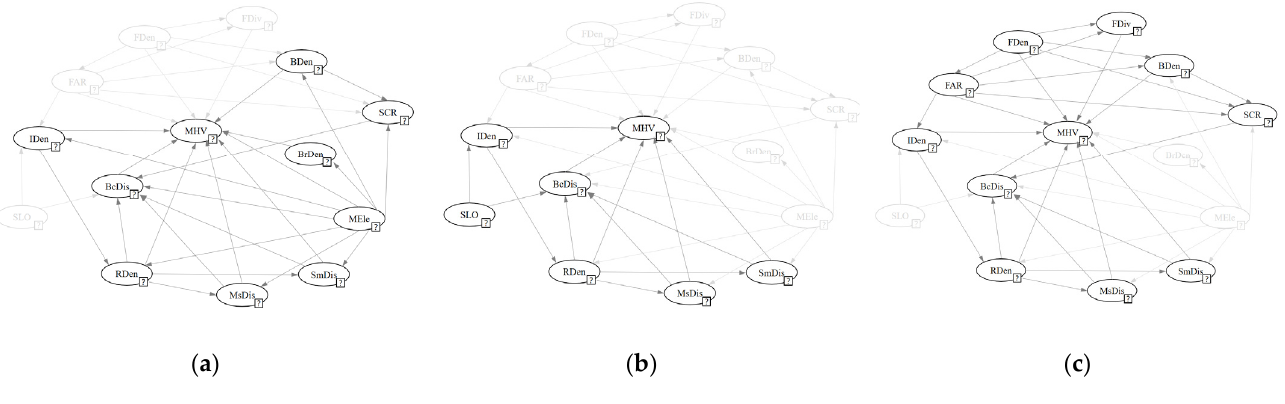
Figure 7. Factor group structure of different root nodes. ( a ) MEle as the root node; ( b ) SLO as the root node; ( c ) FDen as the root node.